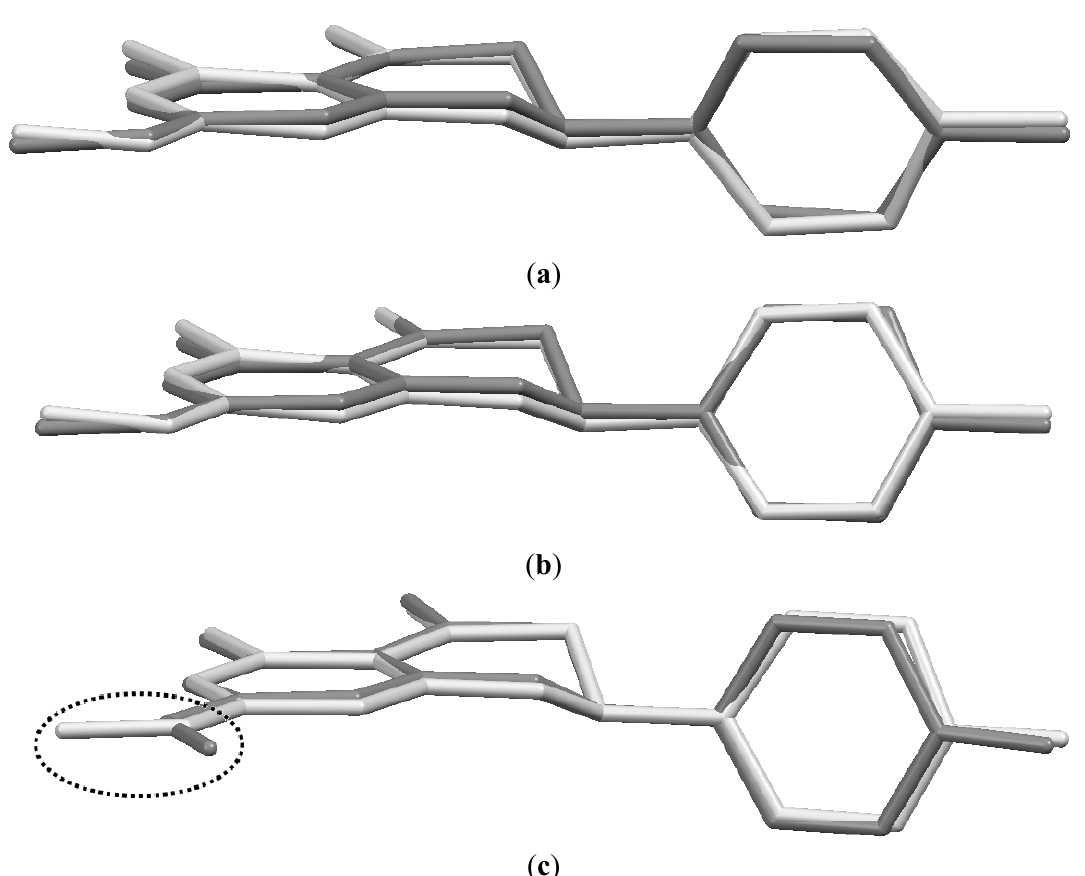
+ B of sakuranetin-monohydrate; a a + B of sakuranetin-monohydrate; and ( c ) conformers A b b and A ; dark grey = B , B and a b a b